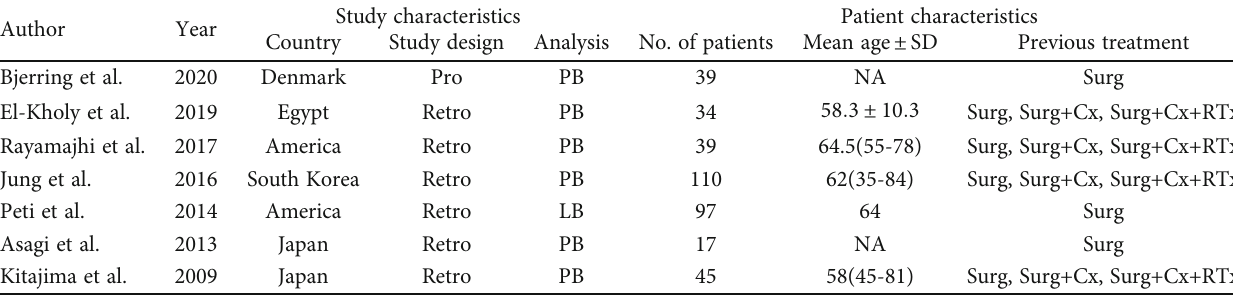
Table 1: Study and patient characteristics of the included